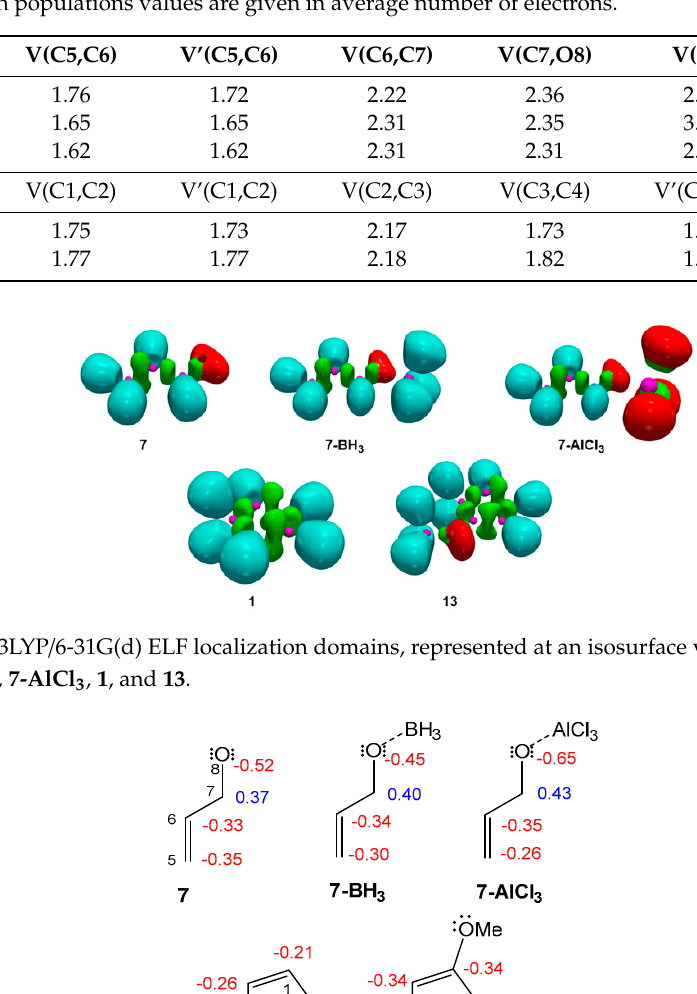
Table 2. Electron localization function (ELF) valence basin populations of 7 , 7-BH 3 , 7-AlCl 3 , 1, and 13 . The electron populations values are given in average number of electrons.